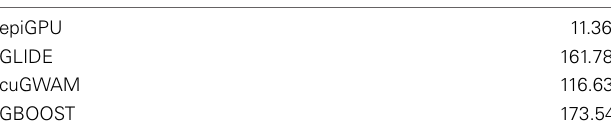
FIGURE 9 | ROC for methods to analyze a binary